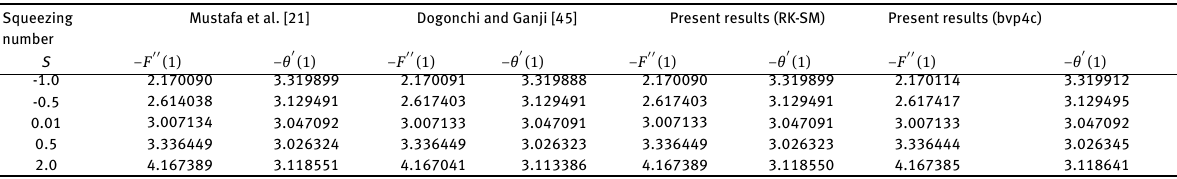
Table 1b: Comparison of present similarity solutions with Mustafa et al. [21] and Dogonchi and Ganji [45] results for F (cid:48)(cid:48) (1) and θ (cid:48) (1) for different values of S when Ha = N b = N t = Ω T = Ω C = 0 Squeezing number